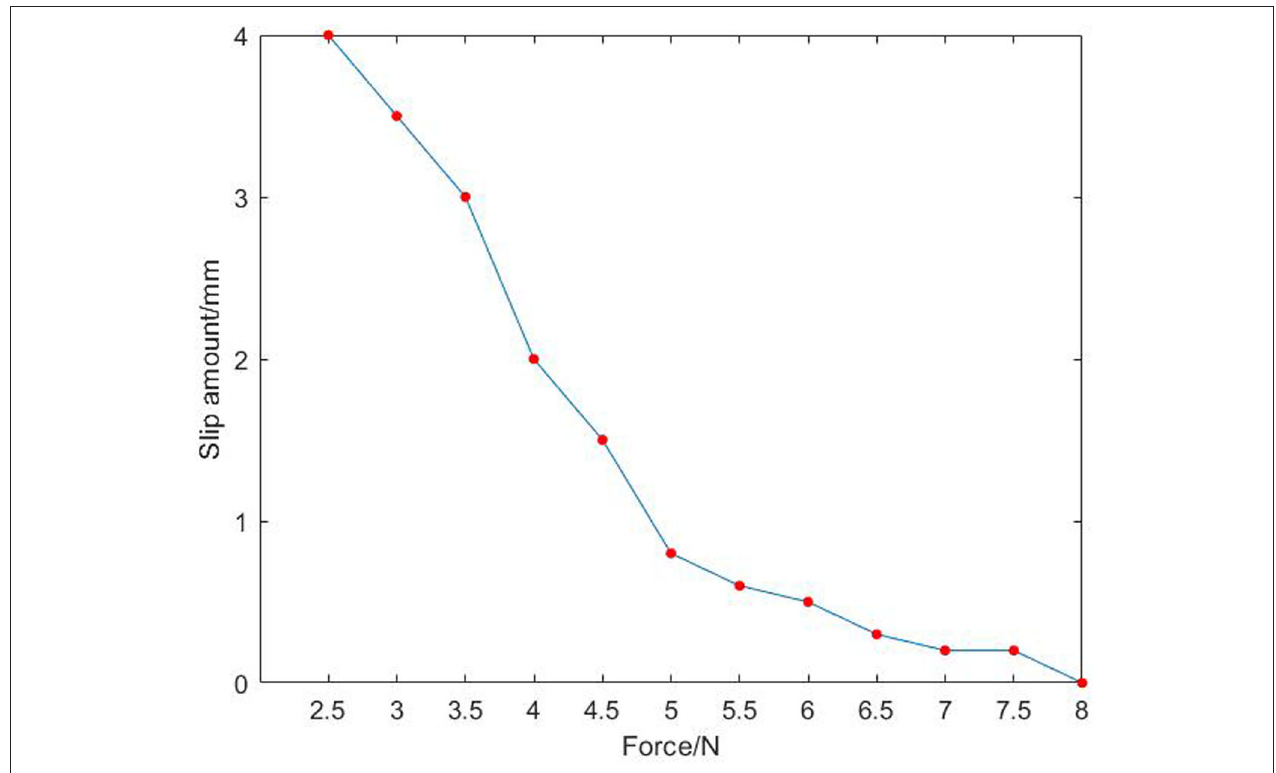
FIGURE 11 | Diagram of the relationship between force and slip after the installation of a sensor.